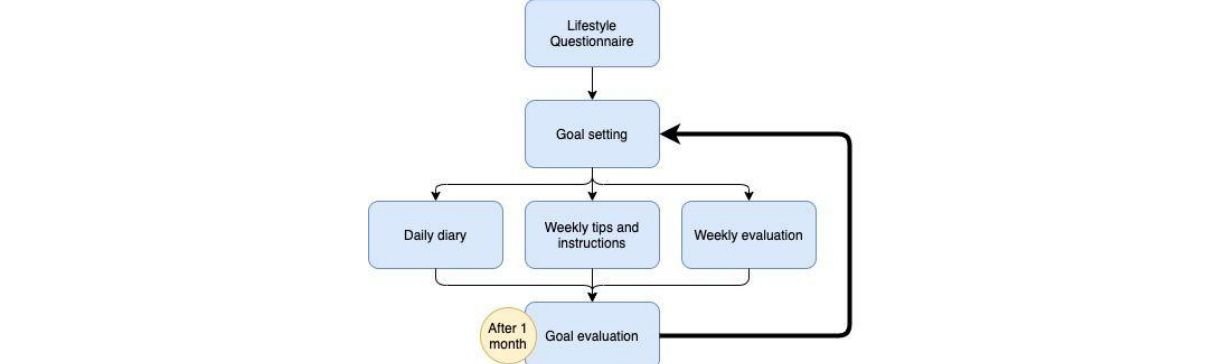
Figure 3. Cycle of the MFB